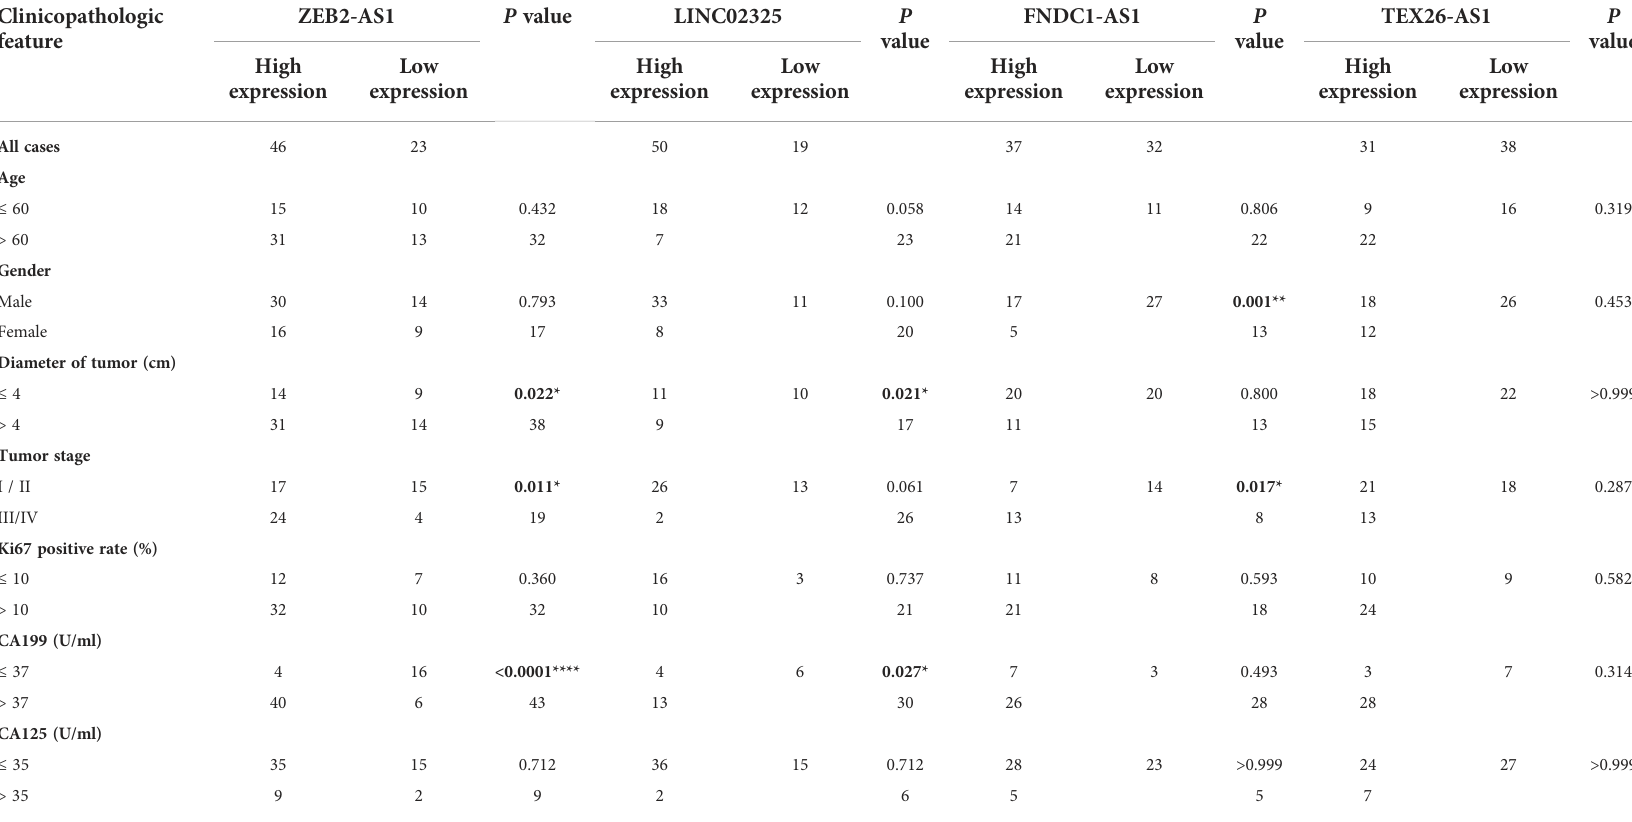
TABLE 2 Correlations between four IRlncRNA expression levels and clinicopathological characteristics in 69 PaCa patients. Clinicopathologic